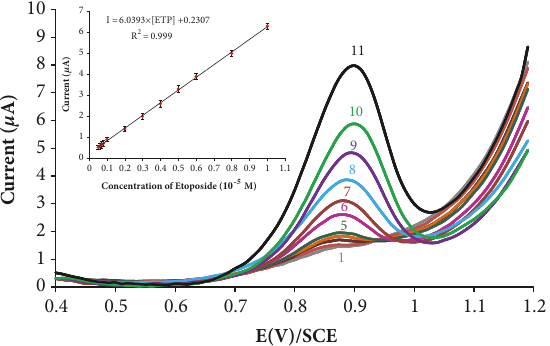
Figure 5:DP voltammograms of MIP/GCE sensor for differentETP concentrations: (1) 5.0 × 10 −7 M; (2) 6.0 × 10 −7 M; (3) 7.0 × 10 −7 M; (4) 8.0 × 10 −7 M; (5) 1.0 × 10 −6 M; (6) 2.0 × 10 −6 M; (7) 3.0 × 10 −6 M; (8) 4.0 × 10 −6 M; (9) 6.0 × 10 −6 M; (10) 8.0 × 10 −6 M; (11) 1.0 × 10 −5 M. Experimental conditions: scan rate: 10 mVs −1 ; pulse amplitude: 50 mV; and pulse width: 20ms. The inset shows the calibration curve. Error bars represent the standard deviation of three independent